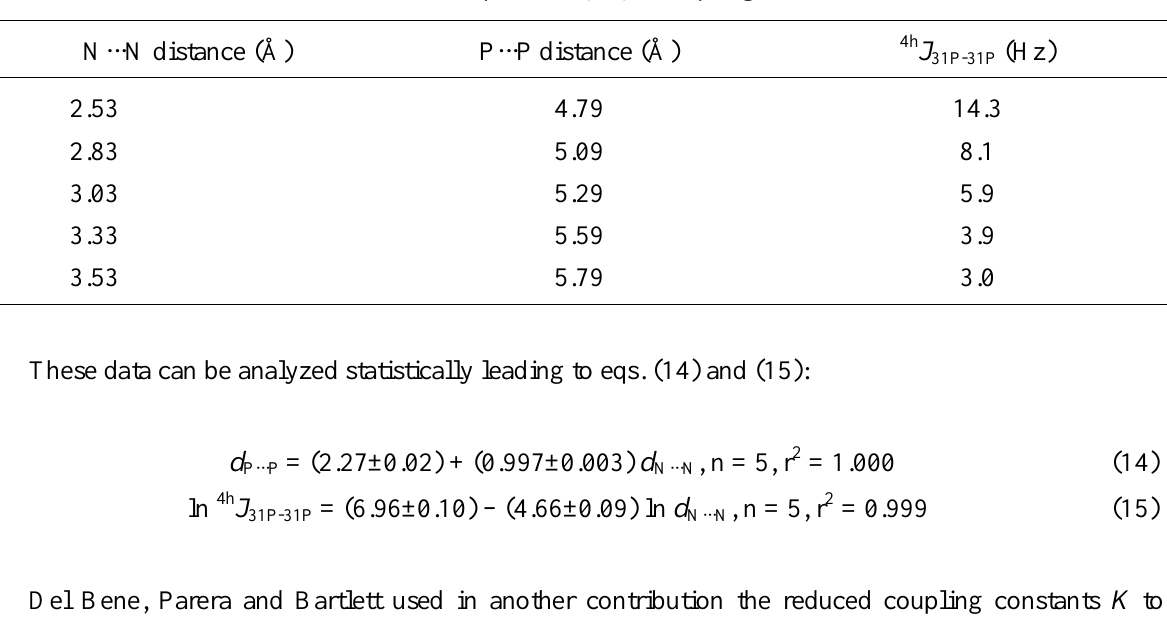
coupling constants in model 25 31P-31P